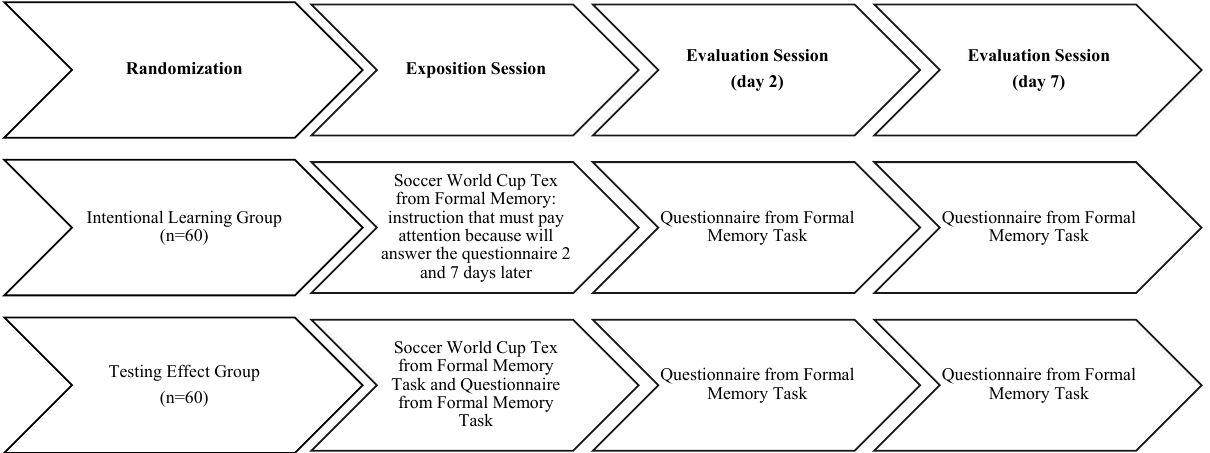
Figure 1 – Design of study